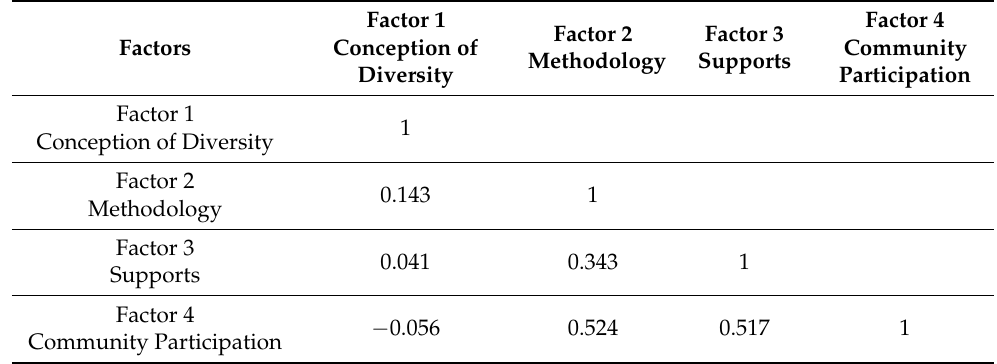
Table 4. CEFI-R inter-factor correlation matrix.